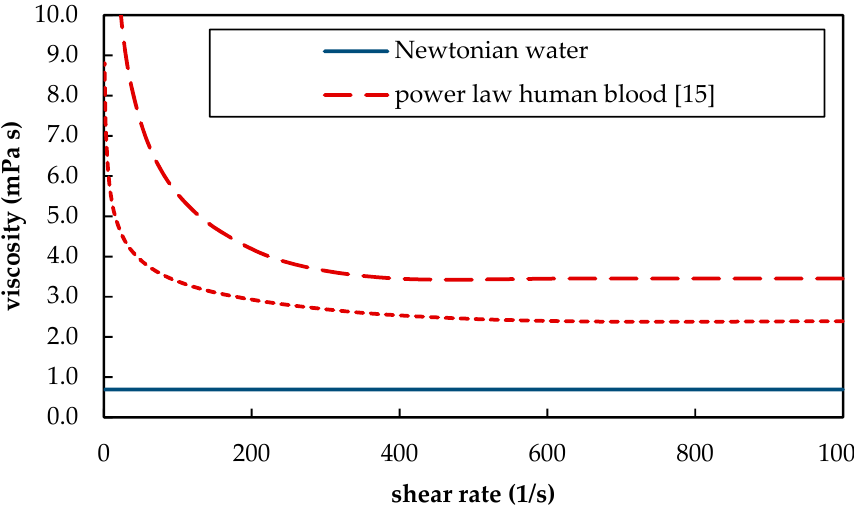
Figure 2. Rheologic behavior of blood and water at 37 ◦ C. For representation of whole blood viscosity, the power law viscosity model was used for human [15] and porcine blood [16].